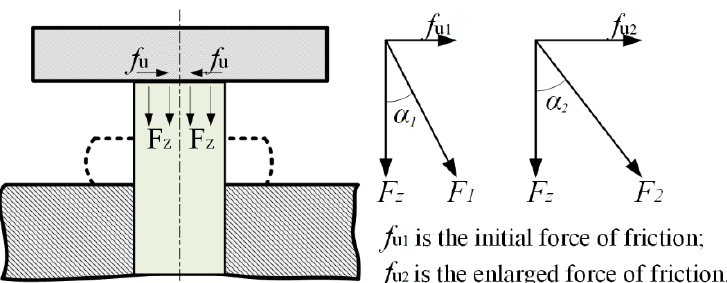
Figure 5. A diagram of the radial force in the central section.